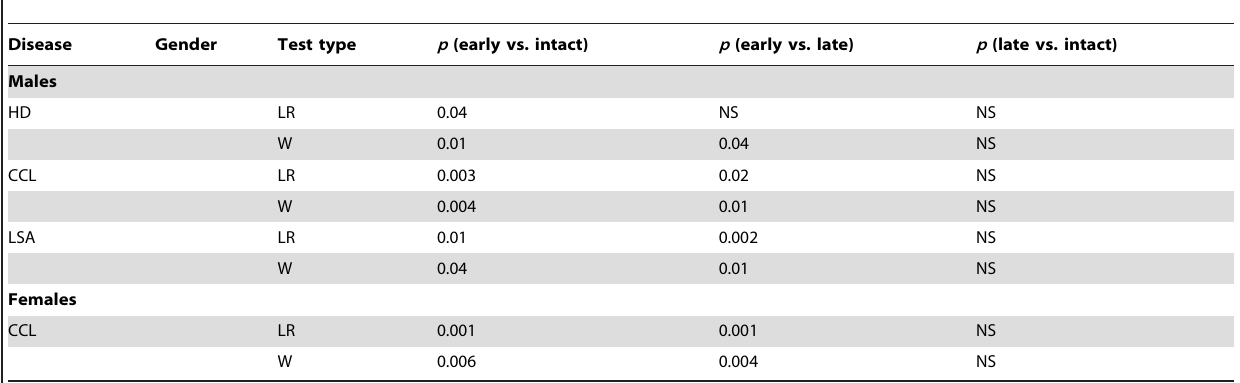
Table 4. Summary of some Kaplan-Meier post hoc comparisons using log-rank (LR) and generalized Wilcoxon (W) tests for male and female Golden Retrievers (1–8 years old) admitted to the Veterinary Medical Hospital, University of California, Davis, from 2000–2009.